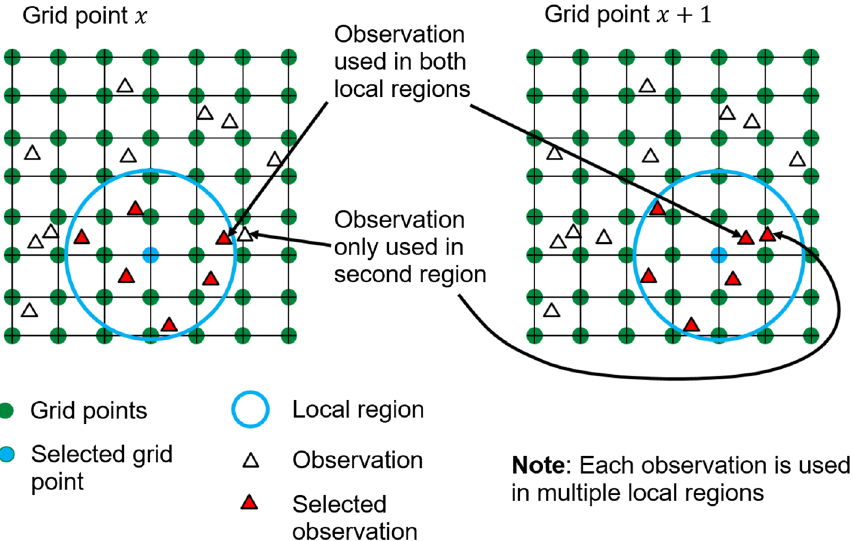
Fig. 1. Cartoon of how the LETKF works. For each grid point (green dots, selected point is blue) a localisation region is drawn (blue circle) and only those observations (red triangles) which are in the localised region are included in the analysis. Cartoon based on that by Kalnay